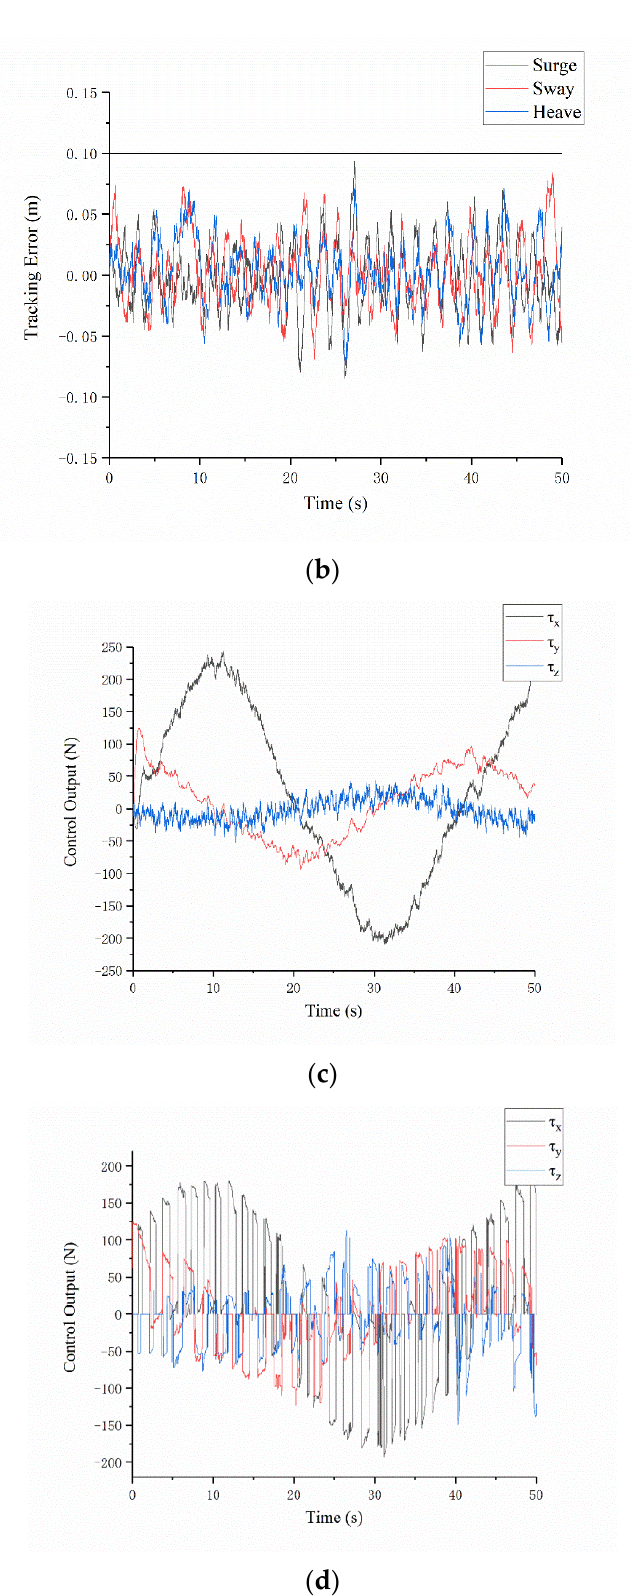
Figure 11. Performance of PRTC scheme and traditional scheme considering uncertain interference and rapid flow perturbations. ( a ) Tracking error of traditional scheme; ( b ) tracking error of PRTC scheme; ( c ) control output of traditional scheme; ( d ) control output of PRTC scheme.